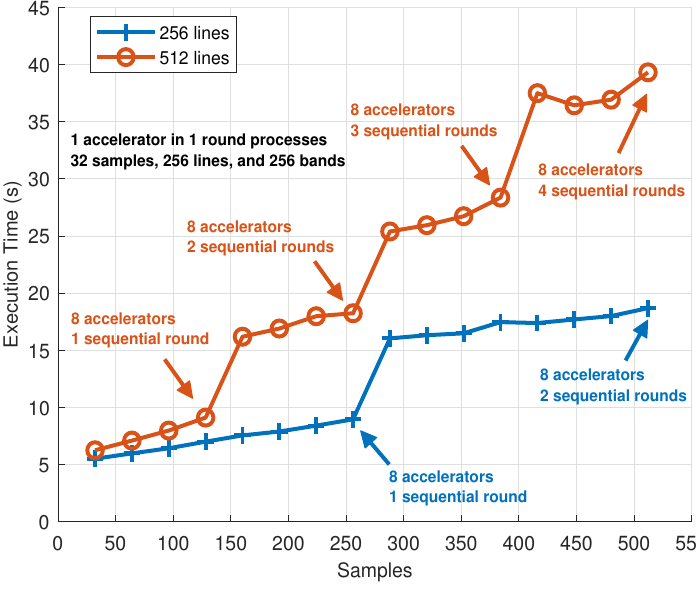
Figure 9. Performance versus image